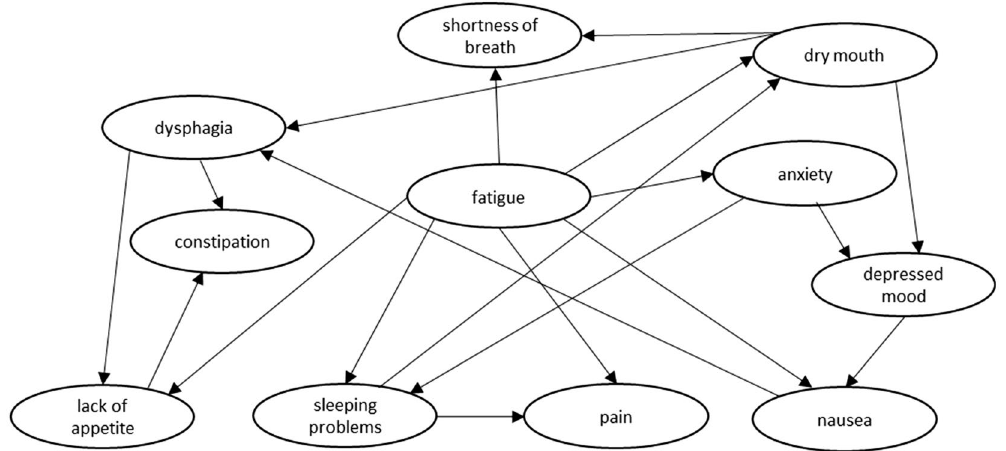
Figure 1. Directed acyclic graph of the Baysian network; as constructed during structure learning by the algorithm with the lowest prediction error estimate (Tabu search algorithm). Edges (arrows) between nodes indicate that the model found a direct association between those variables. An edge points from a parent node towards a child node, indicating that the BN structure found that the child node is conditionally dependent on the parent